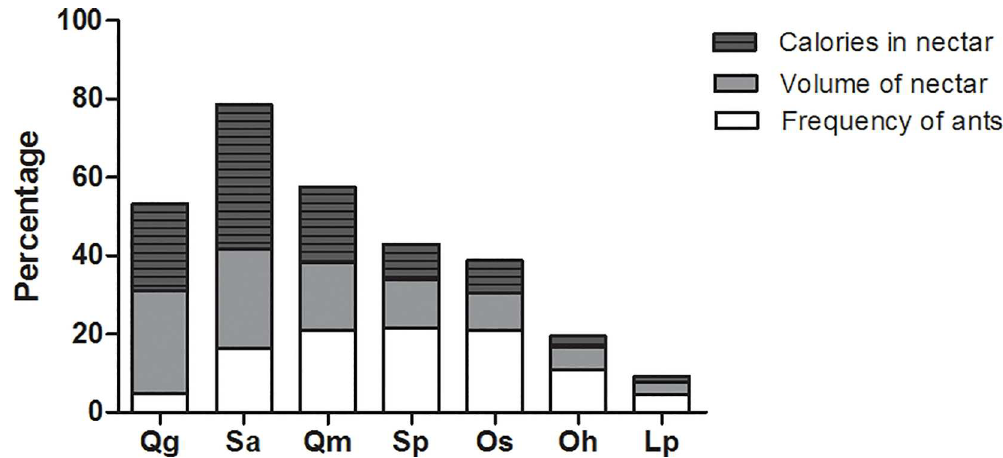
Fig 6. Percentage of relative frequency of ants, total volume of nectar and quantity of calories produced at the EFN in the group of plants (seven species). The letters on the X-axis represent the plant species: (Qg) Qualea grandiflora , (Sa) Stryphnodendronadstringens , (Qm) Q . multiflora , (Sp) S . polyphyllum , (Os) Ouratea spectabilis ,(Oh) O . hexasperma and (Lp) Lafoensiapacari .